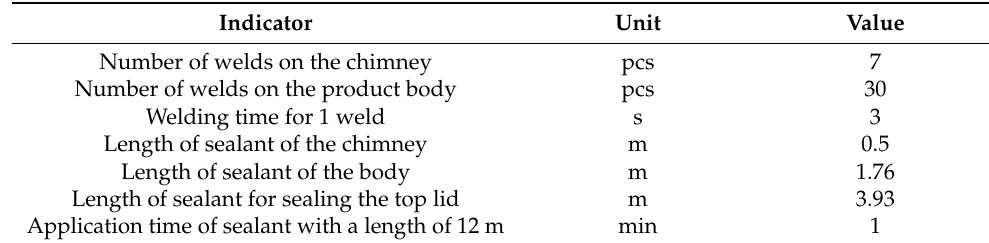
Table 3. Input data for the calculation of times for welding and sealing operations at the Robot workplace.